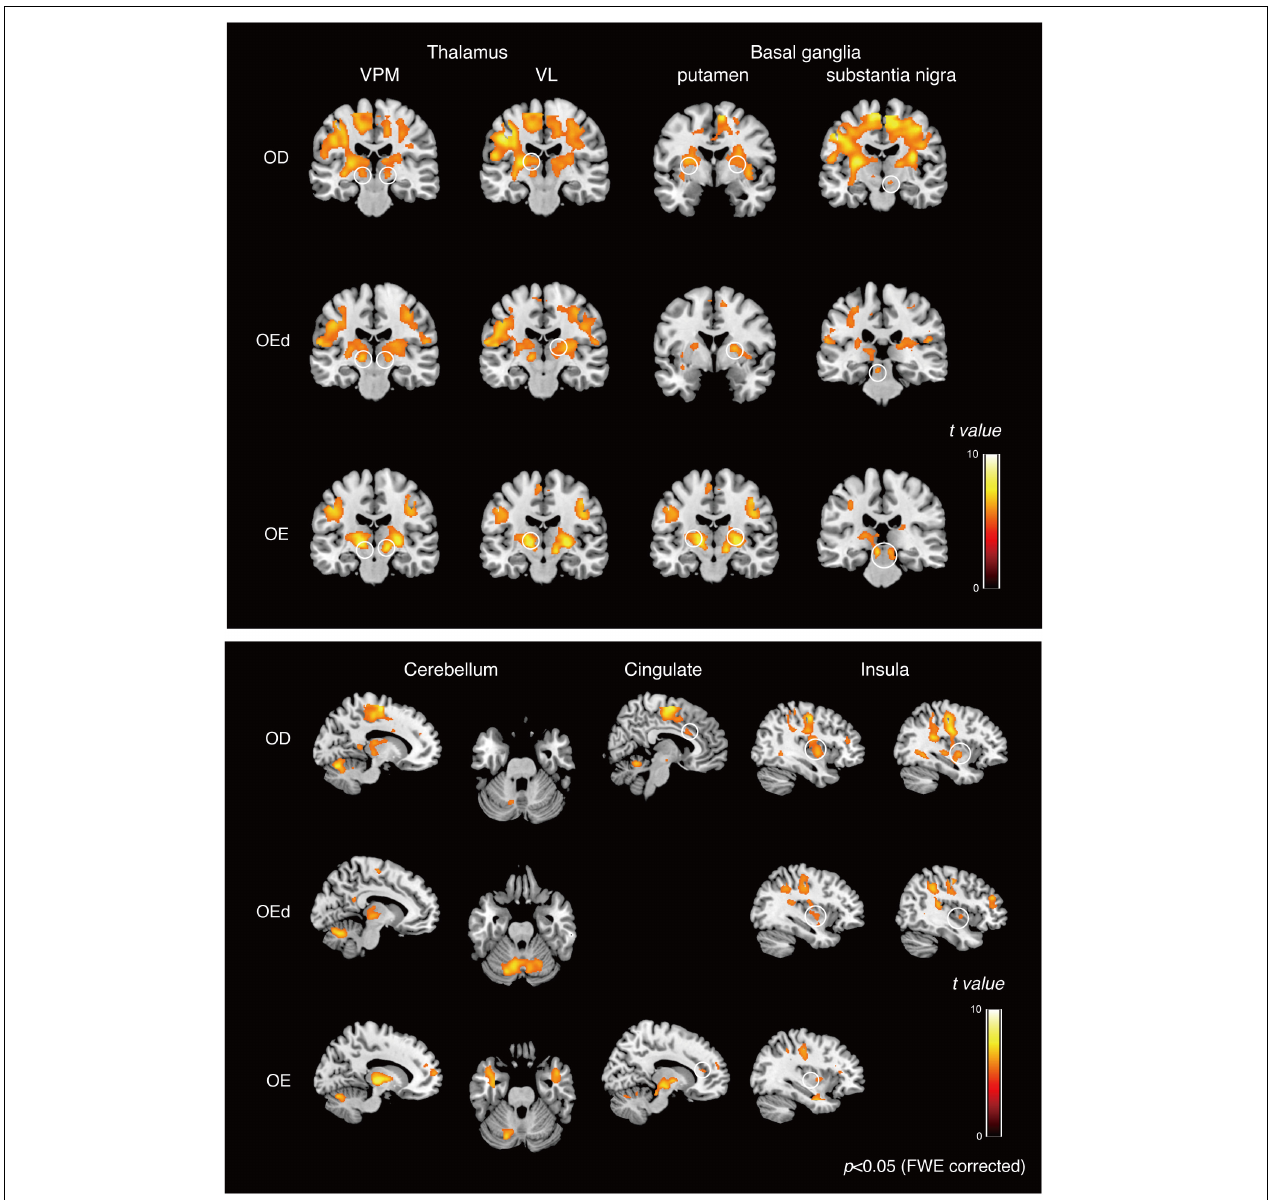
FIGURE 4 | Teeth tapping activated foci in the cortical and subcortical areas in the OD (top) , OEd (middle) , and OE (bottom) groups. Results from GLM analysis were superimposed onto a standard MNI template brain ( p < 0.05, FWE corrected). The color bar shows the t -values. Activated regions, the thalamus (VPM and VL), basal ganglia (putamen and substantia nigra, shown on the coronal planes), cerebellum (shown on the sagittal and coronal planes), cingulate, and insula (shown on the sagittal planes). The color bar shows the t